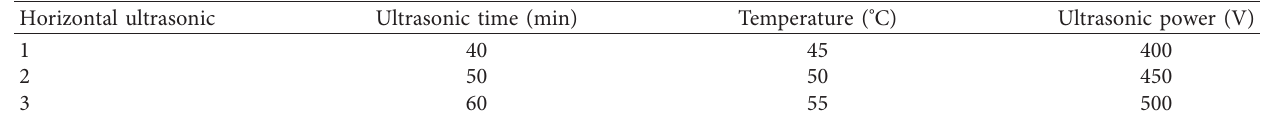
Table 3: Factor levels of the ultrasound-assisted extraction method.